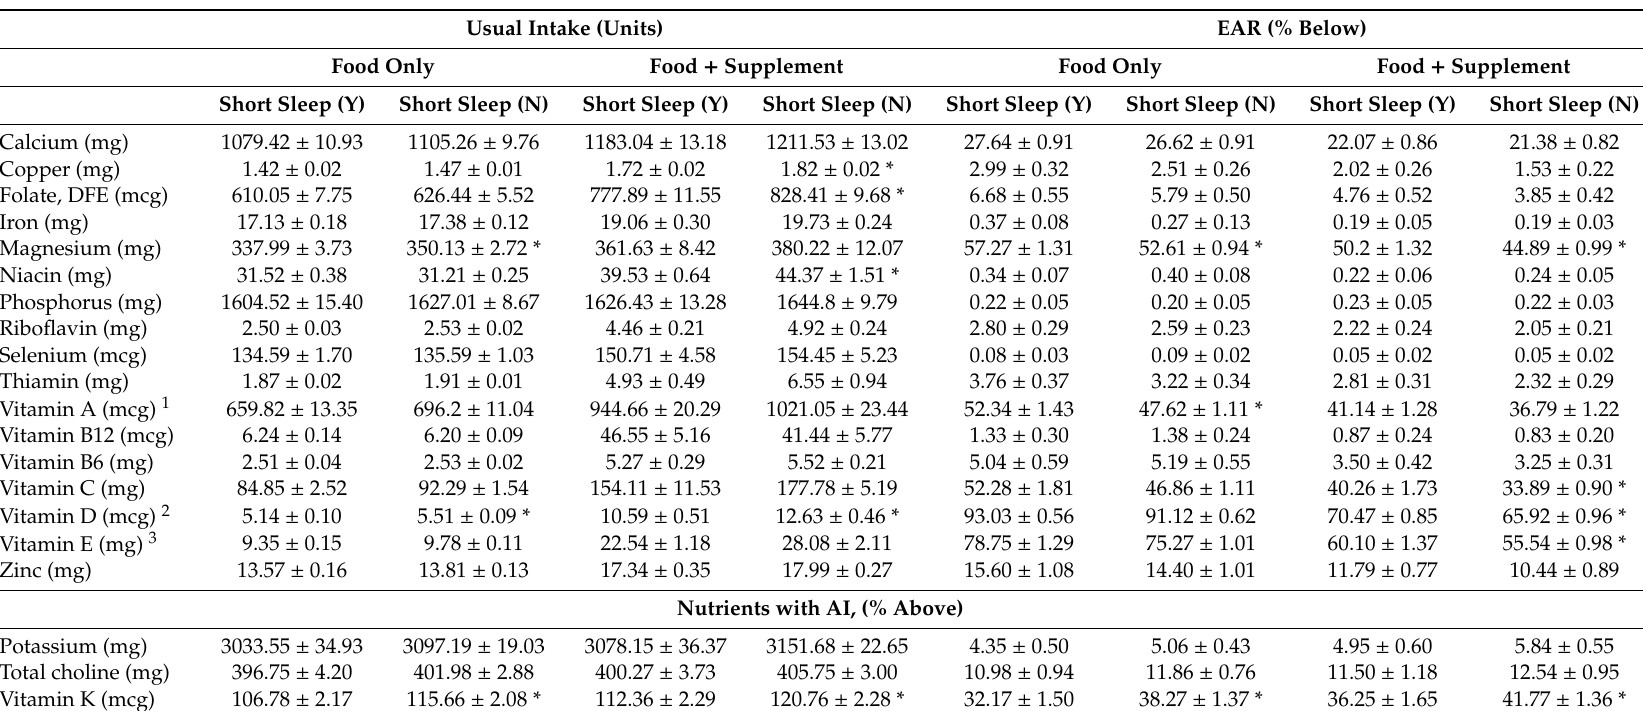
Table 4. Micronutrient usual intake (UI) (Food Only and Food + Spp) and inadequacy (% below estimated average requirement (EAR)) with and without short sleep duration in males aged 19 +